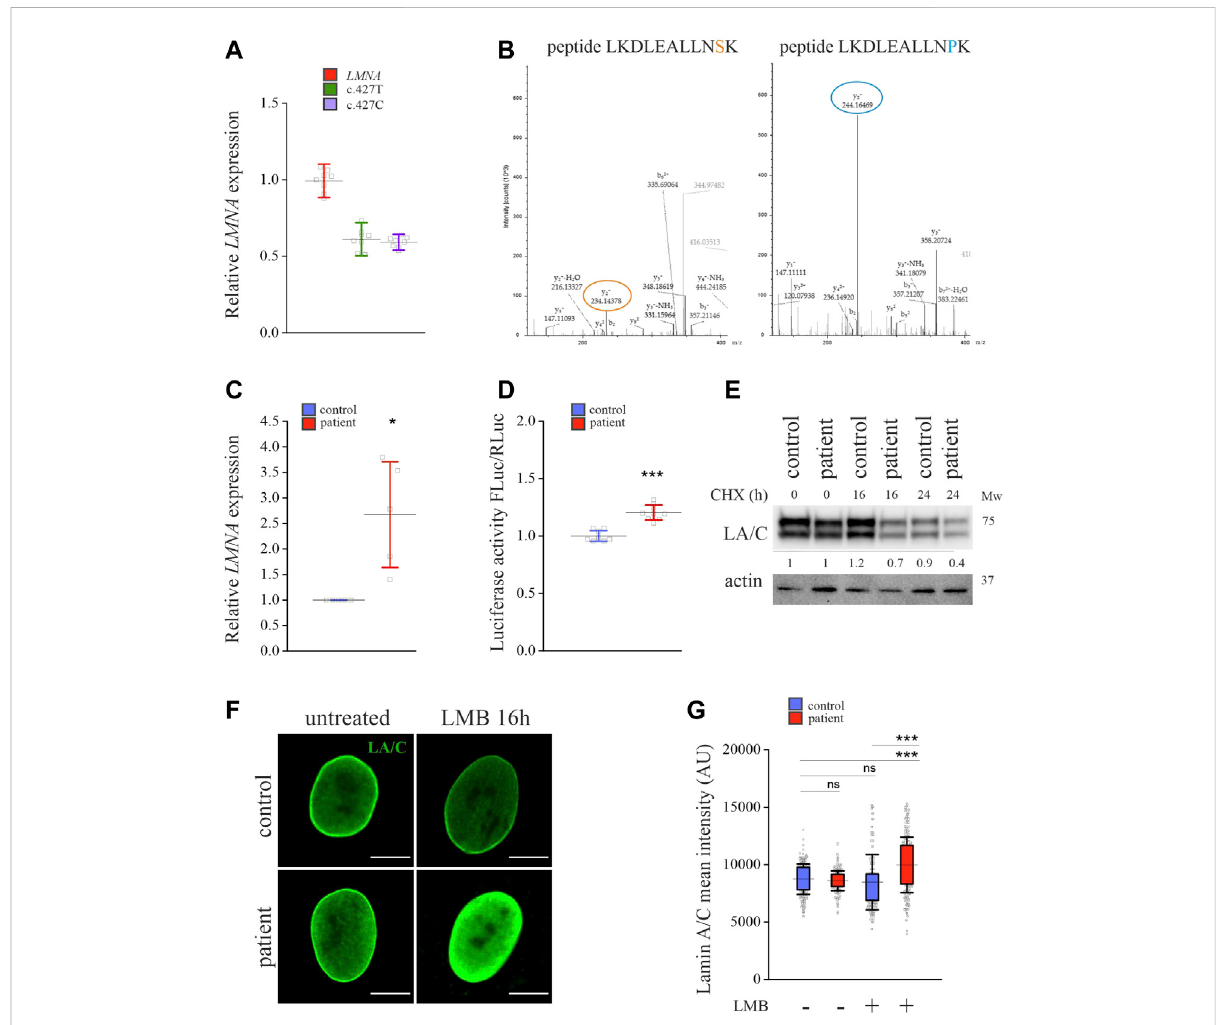
FIGURE 1 Expression and degradation of lamins A and C are enhanced in LMNA mutant patient cells. (A) RT-qPCR analysis of LMNA expression in the patient fi broblasts carrying a heterozygous p.S143P LMNA mutation. Allele-speci fi c primers detecting either wild-type (c.427T) or mutant (c.427C) alleles, or primers detecting both ( LMNA ) were used. N = 3 individual experiments. (B) LC-ESI-MS/MS analysis of peptide fragments covering both wild-type and mutant lamins A and C in the patient cells. The sequences speci fi c to the p.143S and p.143P lamin A and C peptide fragments are shown on the top, and the corresponding peaks in the mass spectra are encircled. (C) RT-qPCR analysis of relative overall LMNA expression in the control and patient fi broblasts (N = 3). (D) Luciferase assay measuring activity of an upstream − 1.3 kb LMNA promotor sequence in the control and patient fi broblasts (N = 3). (E) Western blot analysis shows protein levels of lamins A and C (LA/C) in the patient and control fi broblasts treated with 300 μ g/ml cycloheximide (CHX) for given time points. Numerical values show levels of lamins A and C normalized to actin, which was used as